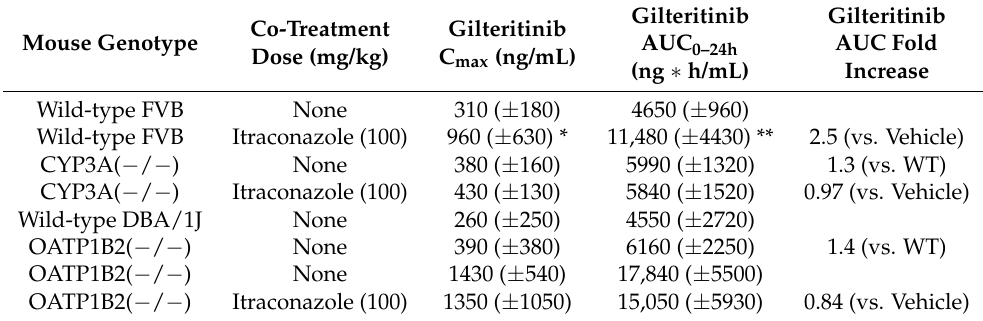
Table 1. Gilteritinib pharmacokinetic